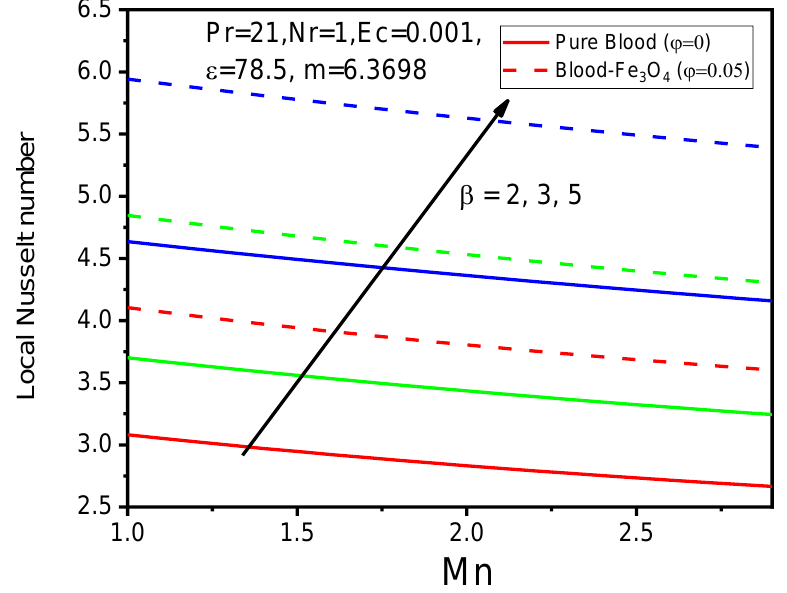
Figure 18. (Case a): Values of the local Nusselt number for different values of β against Mn .